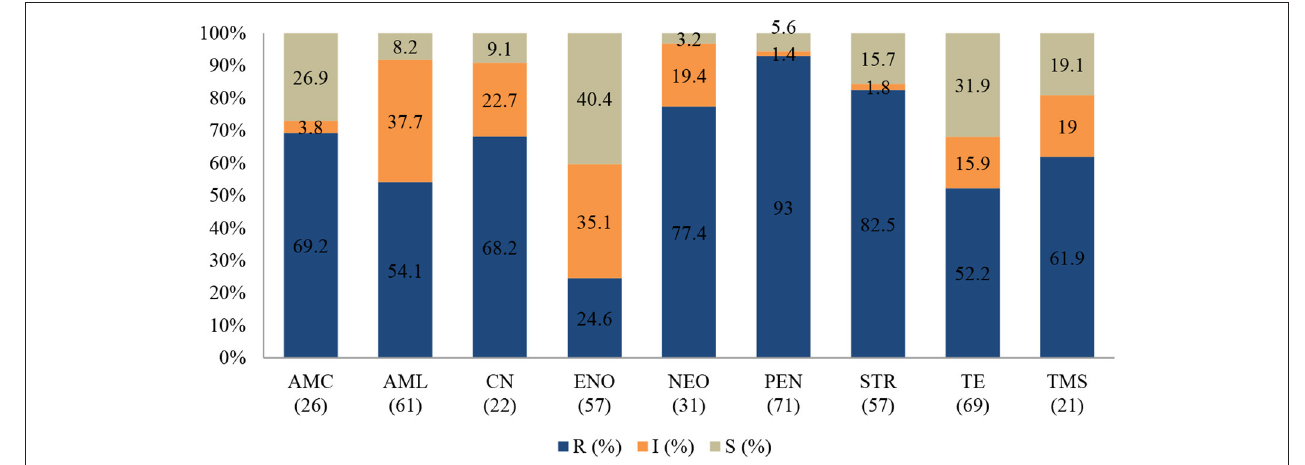
FIGURE 2 | Antibiotic susceptibility pattern of Escherichia coli isolates from diseased ruminants (January 2015-December 2017). R-resistance; I-intermediate; S-susceptible; AMC-amoxicillin/clavulanic acid; AML-amoxicillin; CN-gentamicin; ENO enrofloxacin; NEO-neomycin; PEN-penicillin; STR-streptomycin; TE-tetracycline; TMS-trimethoprim/sulfamethoxazole; Numbers inside brackets “()” indicate total number of tested isolates for each